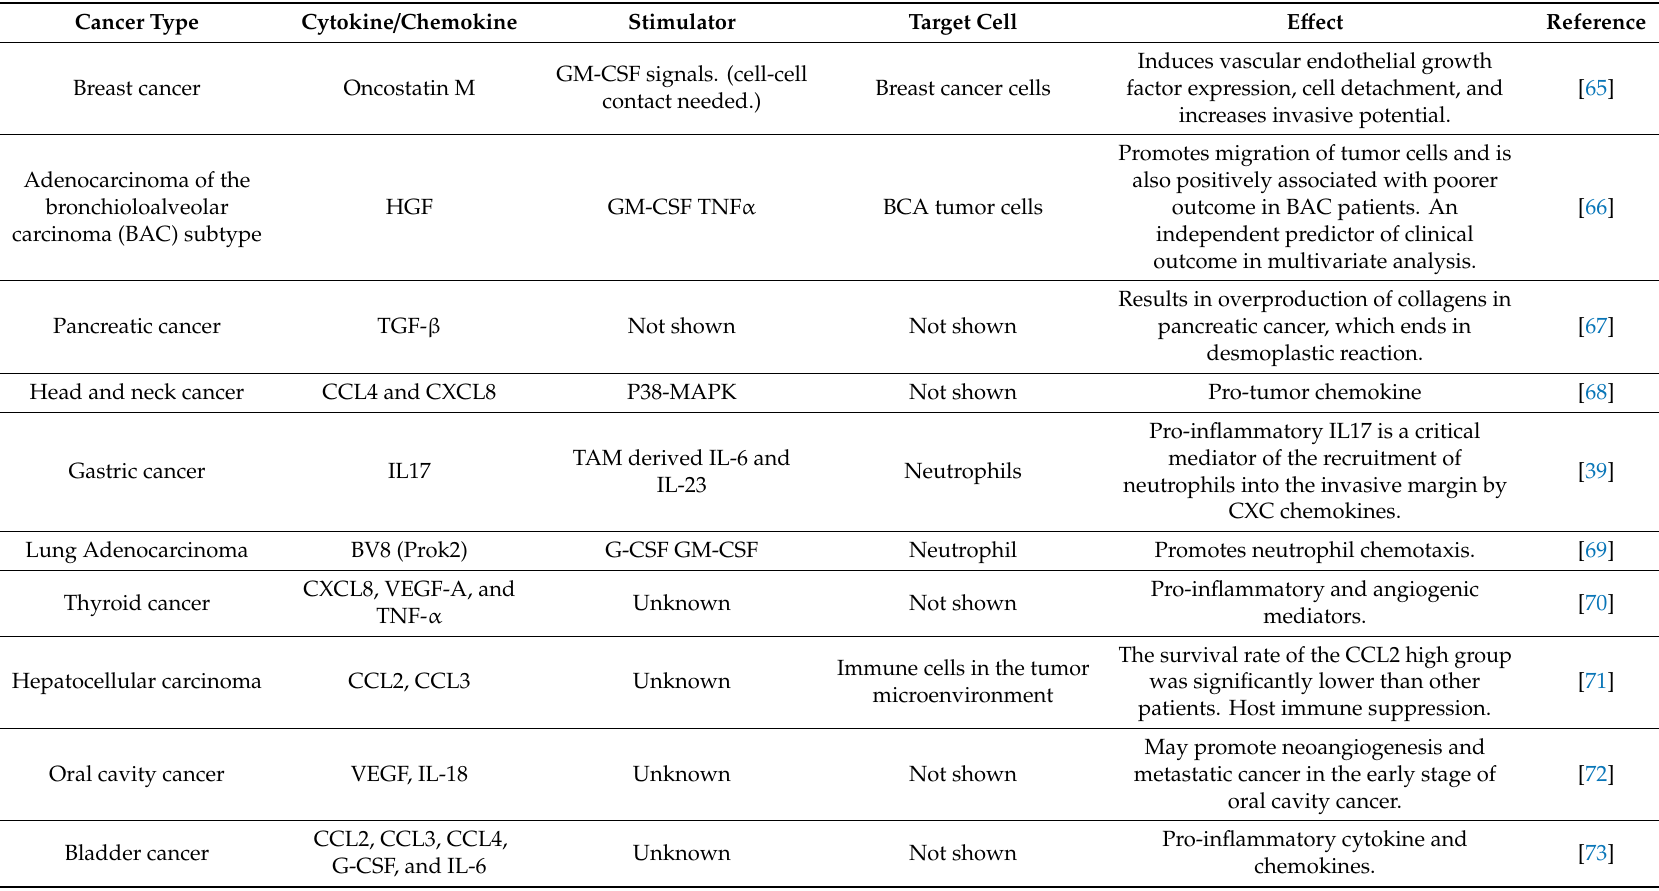
Table 1. Neutrophil produced cytokines and chemokines in human